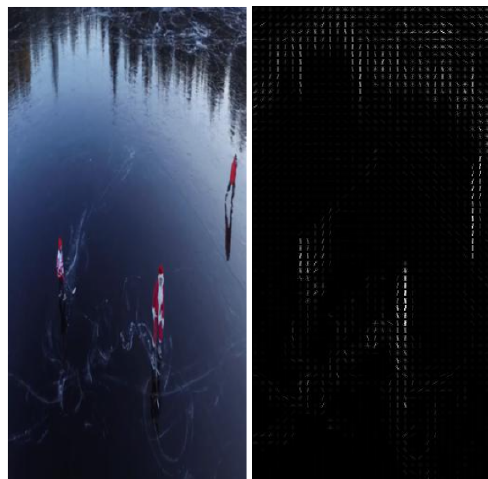
Figure 15. Resized frame and HOG output.